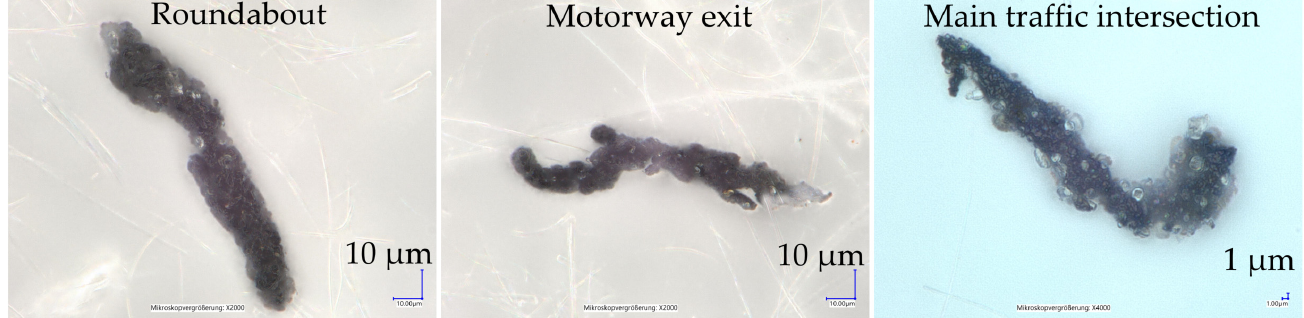
Figure 11. Microscopy of particles on the filter of the measuring station.